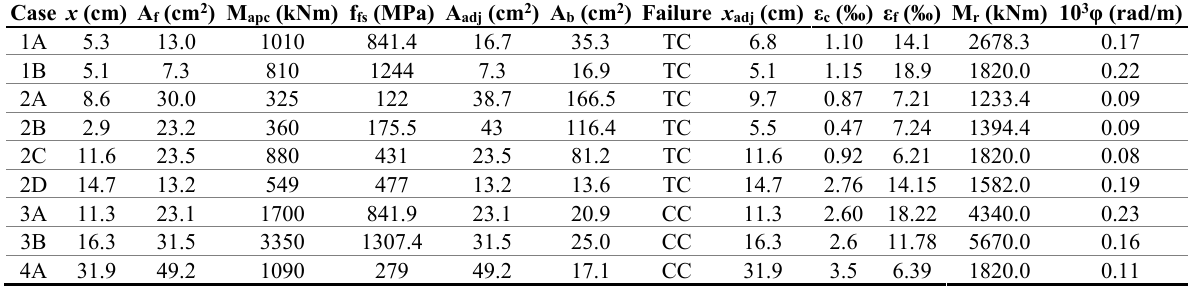
Table 3. Design for the ultimate limit state and checking for creep rupture for all